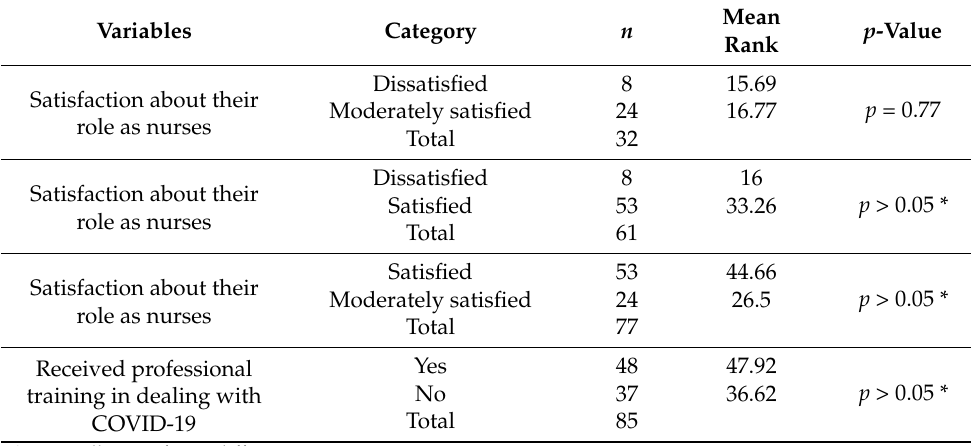
Table 6. Pairwise comparisons for the professional self-concept